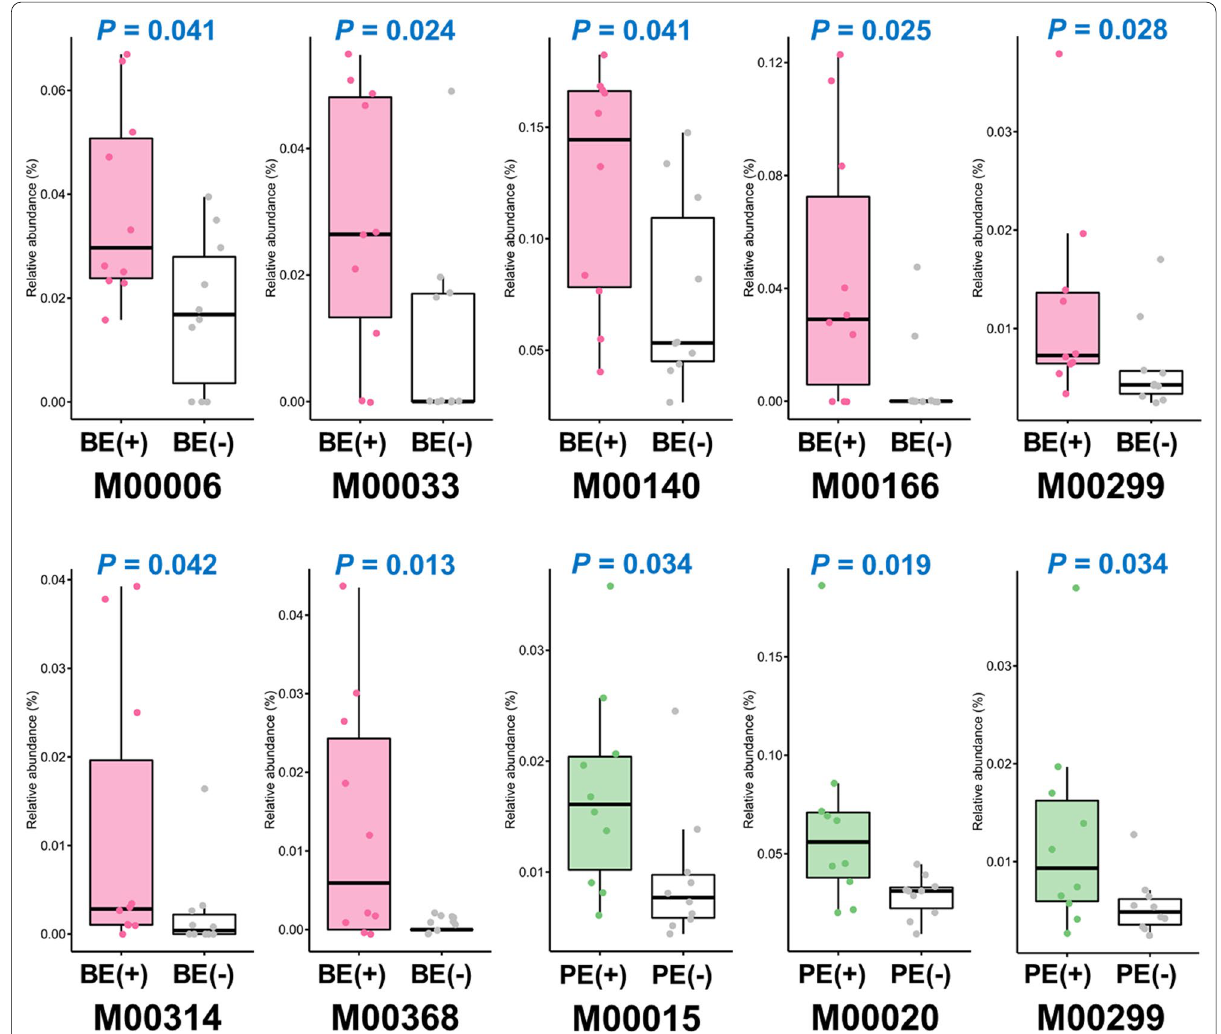
Fig. 4 Differentially abundant major KEGG modules by microbial inoculations. Individual data points were jittered on each boxplot. BE, bacterial-enriched rumen fluid; PE, protozoal-enriched rumen